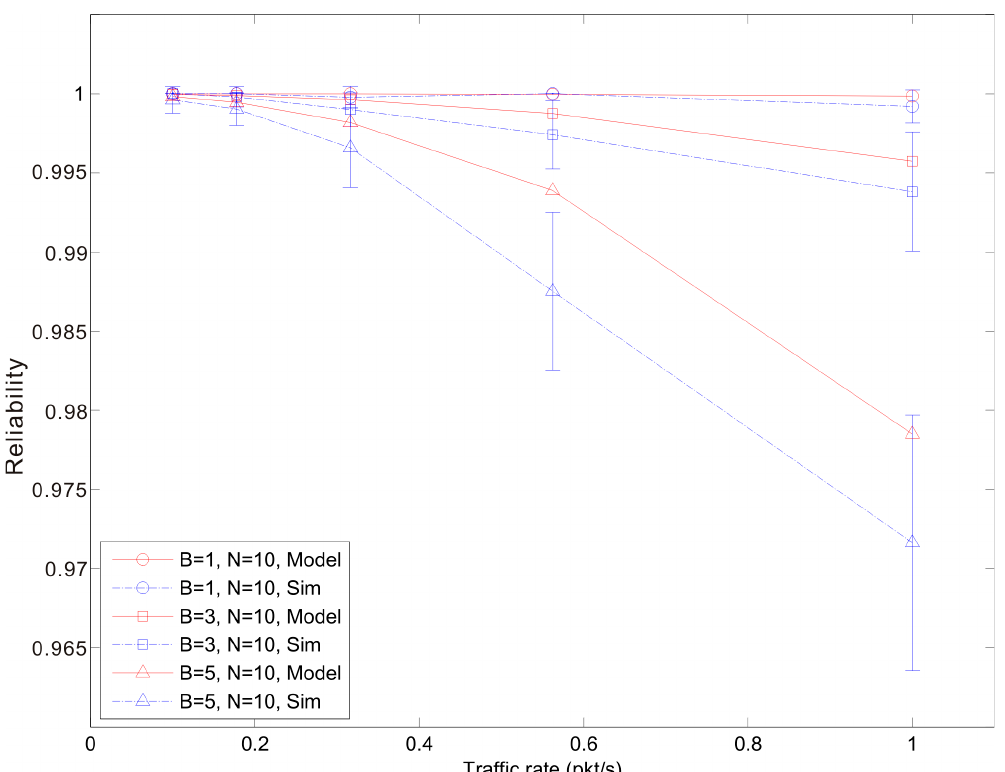
Figure 7. Blockwise reliability versus traffic rate for a star topology network composed by 10